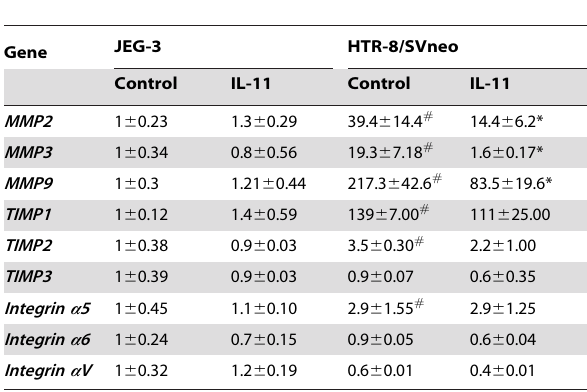
Table 2. Effect of IL-11 on the expression of MMPs, TIMPs and